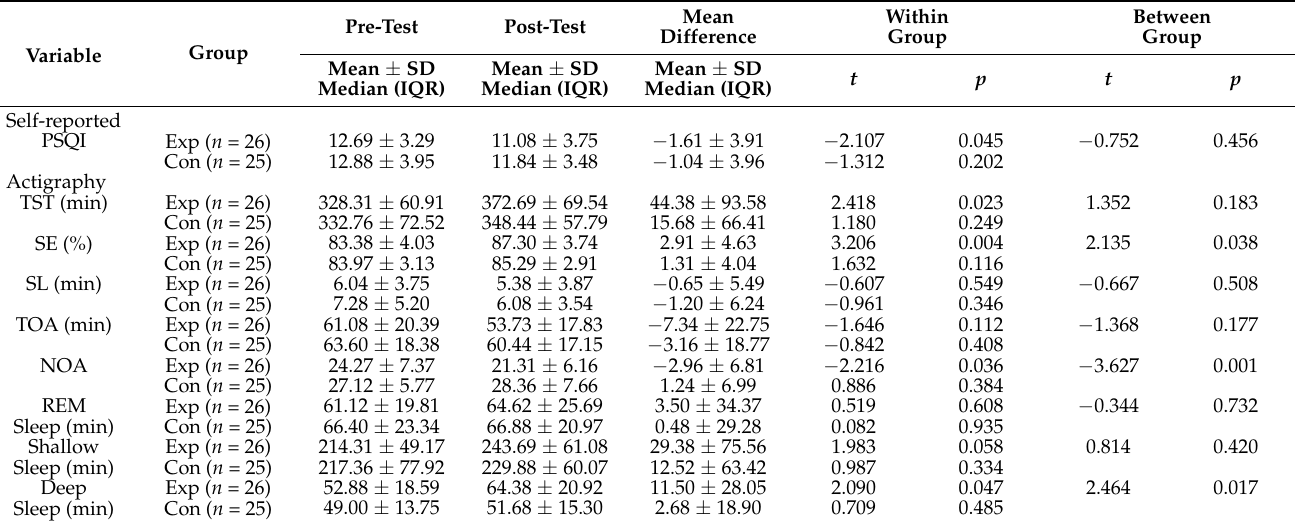
Table 5. Comparison of sleep-related dependent variables between groups ( n =